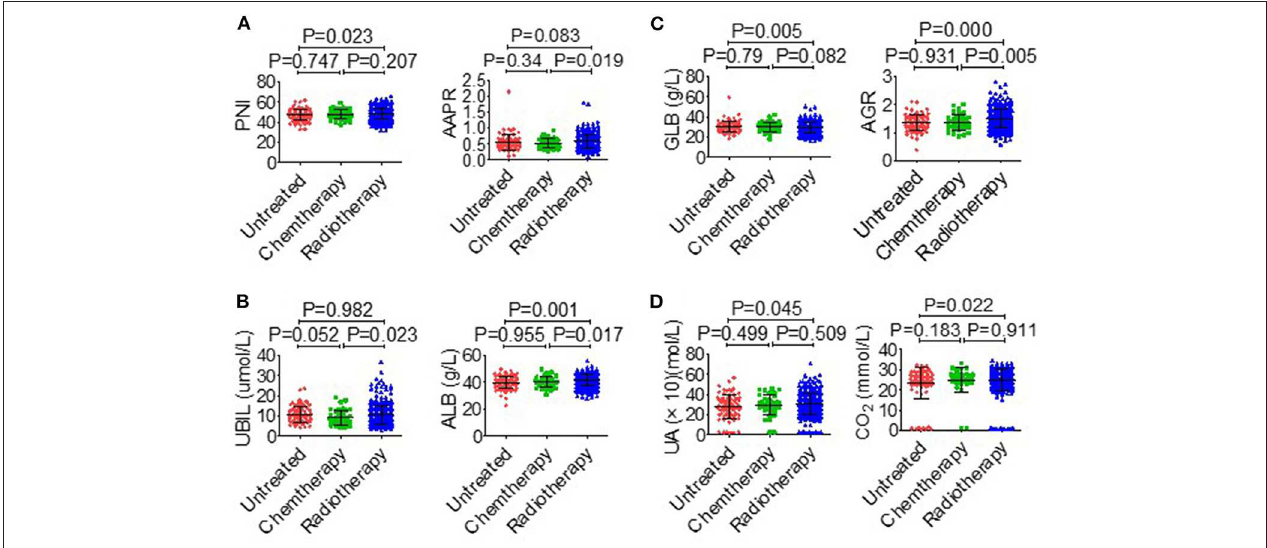
FIGURE 3 | Effects of therapy on serological parameters. (A) PNI (left), AAPR (right). (B) UBIL (left), ALB (right). (C) GLB (left), AGR (right). (D) UA (left), CO 2 (right).